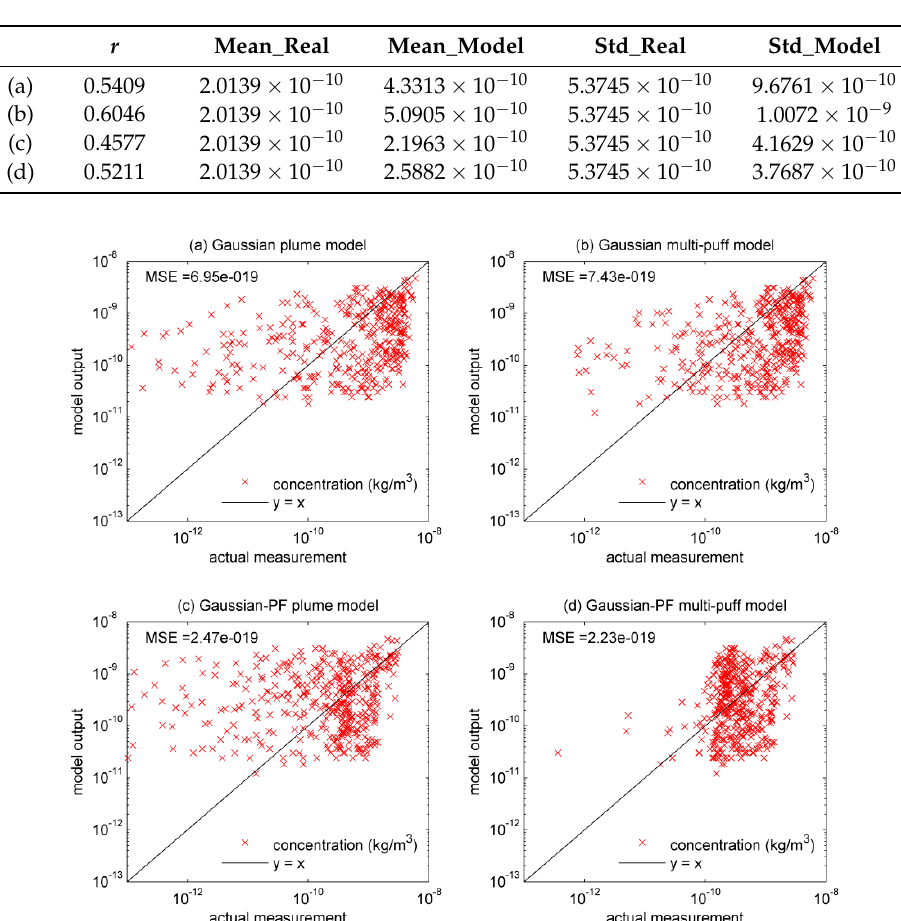
Figure 3. Comparisons of real measurements and modeled concentrations calculated by ( a ) Gaussian plume model; ( b ) Gaussian multi-puff model; ( c ) Gaussian-PF plume model, and ( d ) Gaussian-PF multi-puff model.